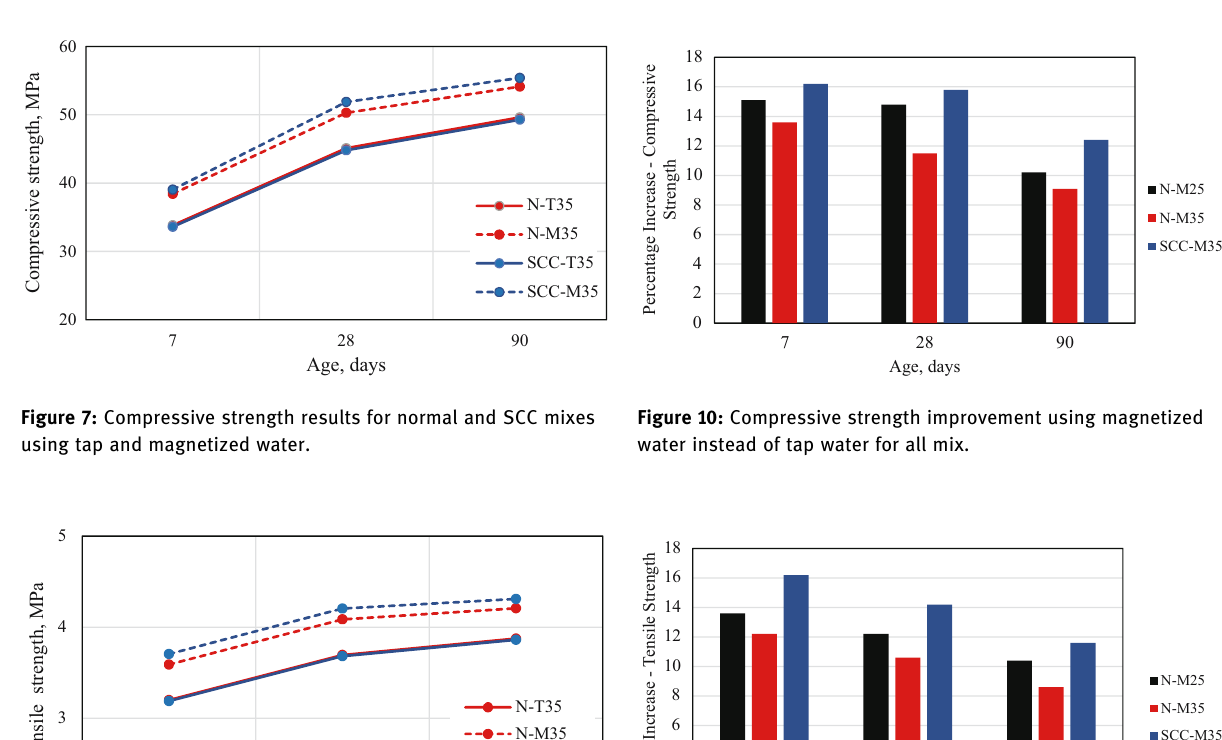
Figure 9: Flexural strength results for normal and SCC mixes using tap and magnetized water.